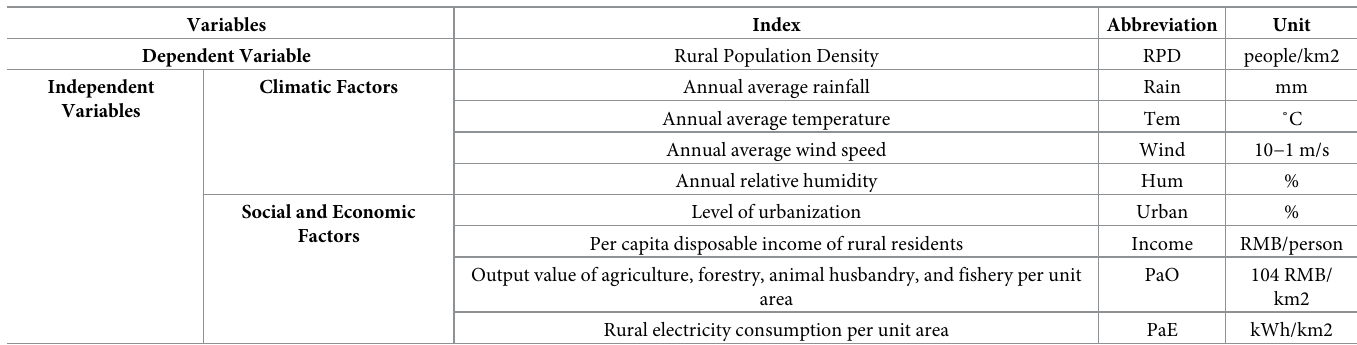
Table 2. Selection of variables.